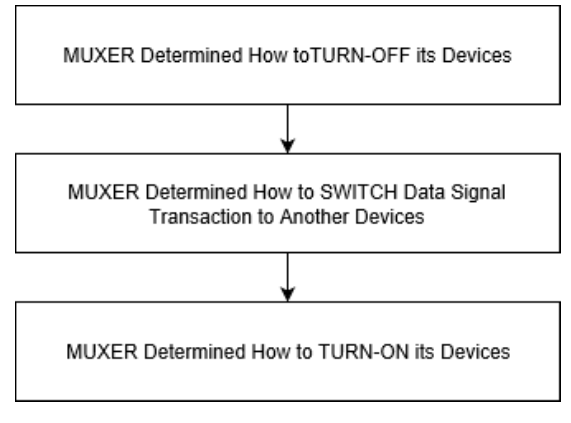
Figure 1. Main processes of MUXER.